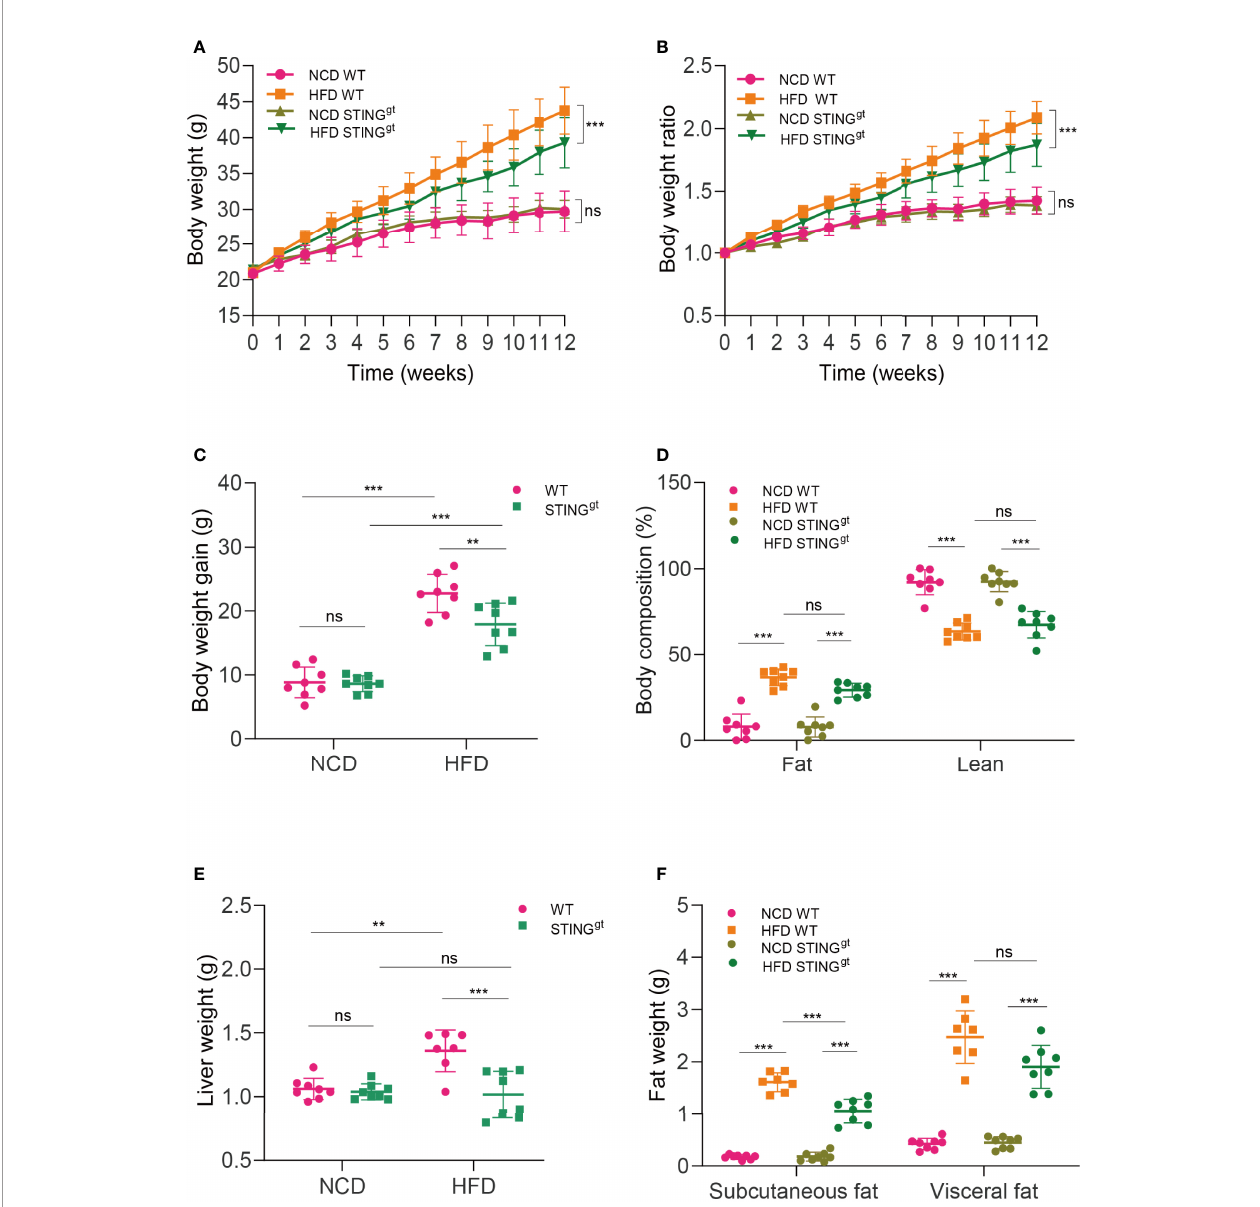
FIGURE 1 | STING de fi ciency downregulates body weight and liver and fat weight in NAFLD mice. WT and STING gt mice were fed NCD or HFD for 12 weeks at 6 weeks of age. (A – C) Body weight, body weight ratio, and body weight gain were determined. (D) Body composition (fat and lean content) was also measured. (E, F) Measurements of liver and fat weight (subcutaneous fat and visceral epididymal fat) at 12 weeks. ns, no signi fi cance; NCD, normal chow diet; HFD, high-fat diet; WT, wild-type; STING gt , STING-deletion mice. Data are expressed as mean ± SD, n = 6 – 8 per group. **p < 0.01, ***p < 0.001 (unpaired t -test or